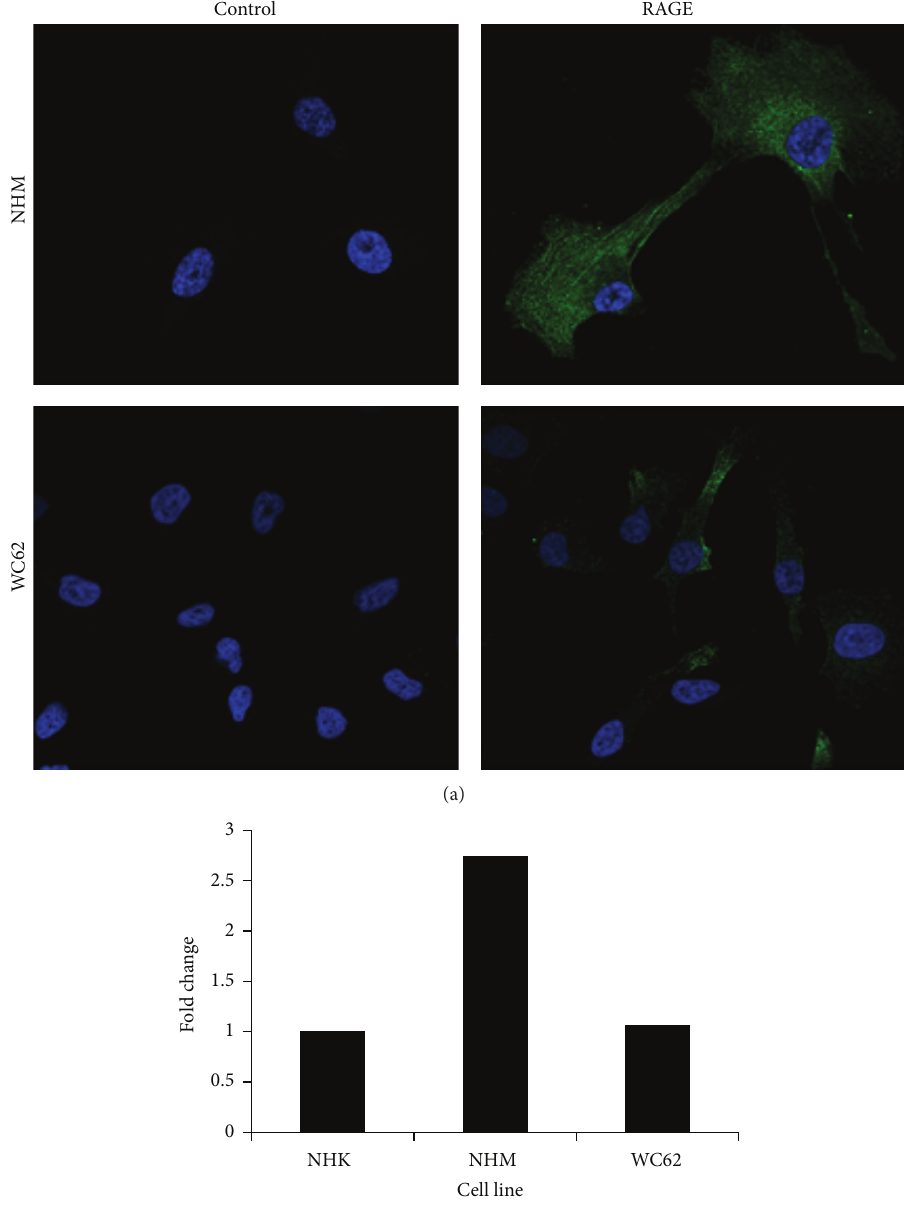
Figure 1: Expression of the calprotectin receptor RAGE on melanocytes and melanoma cells. NHM or WC62 cells were labeled with anti- RAGE primary antibodies followed by fluorescently labeled secondary antibody, as described in Materials and Methods, and examined by confocalmicroscopy.ControlsamplesweretreatedwithaproteinconcentrationofnormalgoatIgGequivalenttothatoftheprimaryantibody.